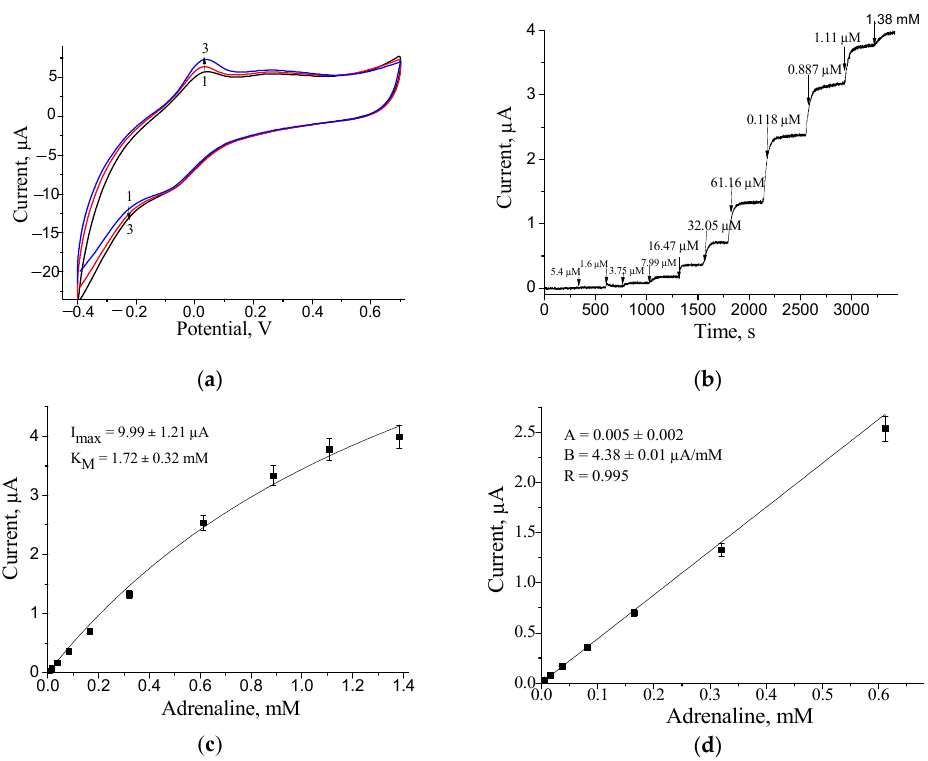
Figure 5. Characteristics of laccase/GE: CV as current responses upon AD addition up to 0 mM (1, black line), 4 µM (2, red line) and 8 µM (3, blue line) concentrations ( a ); chronamperometric response ( b ), dependence of amperometric signal on concentration of AD ( c ) and calibration graph ( d ) under working potential +100 mV.